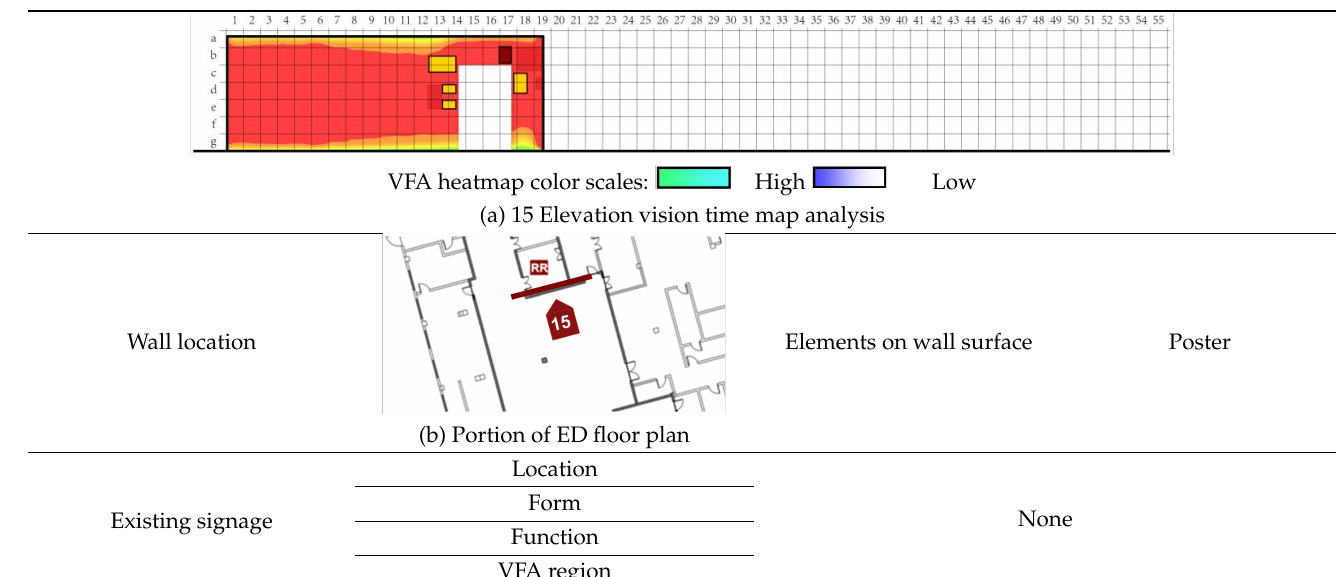
Table 19. 15 Elevation comparative